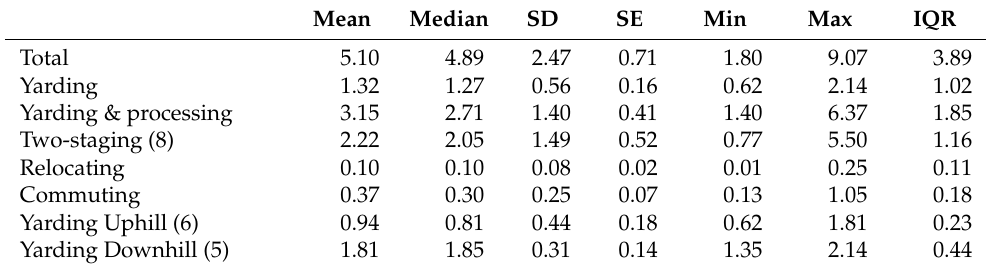
Table 4. Diesel fuel consumption (L m − 3 ) by task: descriptive statistics.